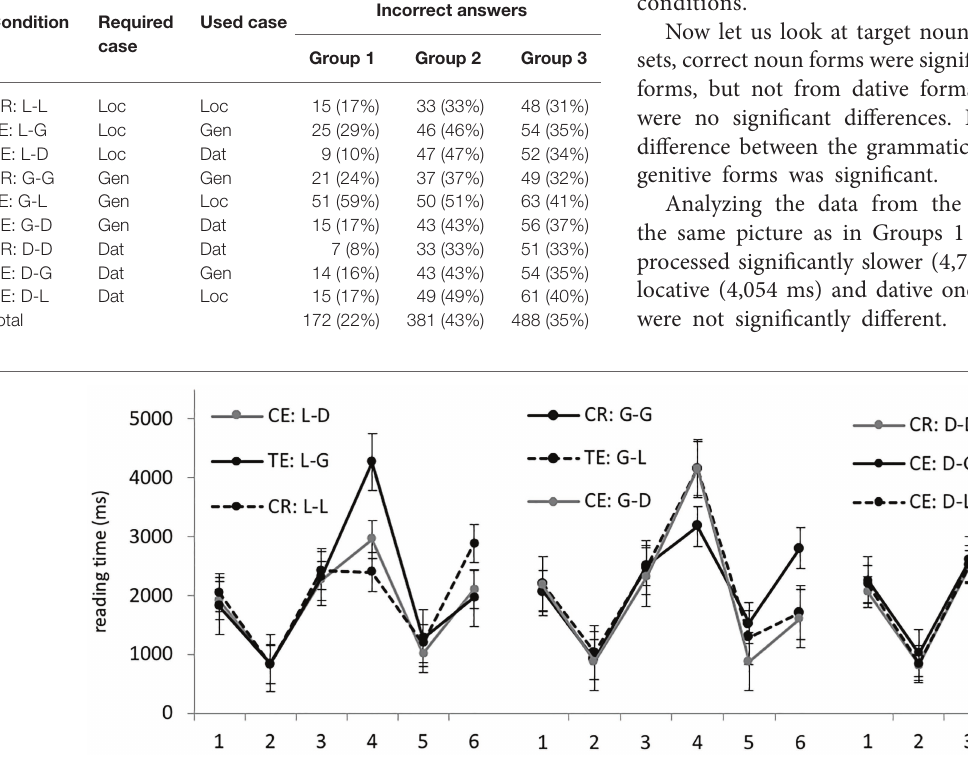
FIGURE 3 | Group 2: average RTs per region (in ms) in the nine experimental conditions.